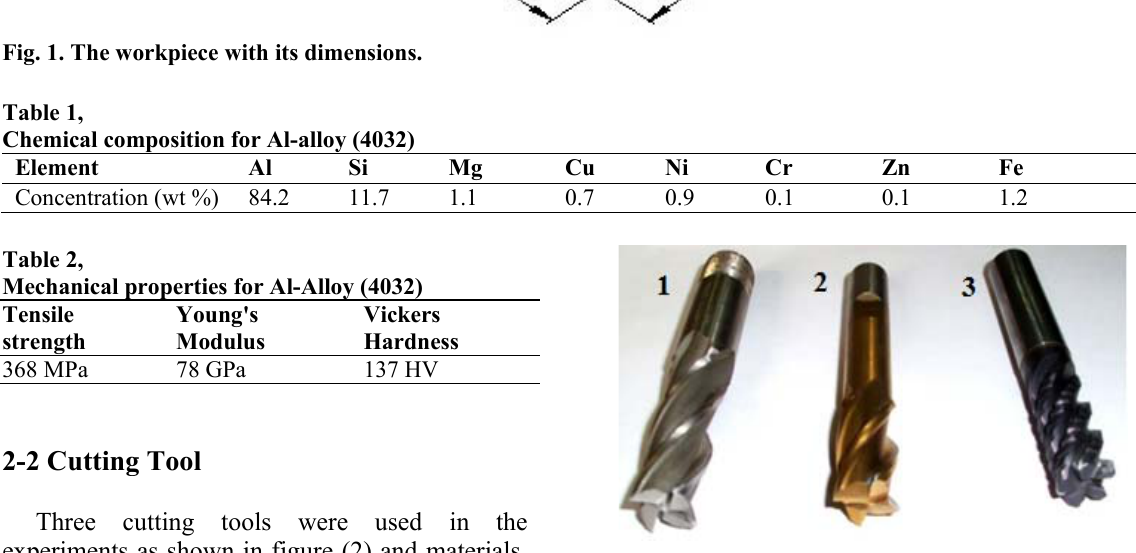
Fig. 2. Tools (end mill cutters) used in experimental work.